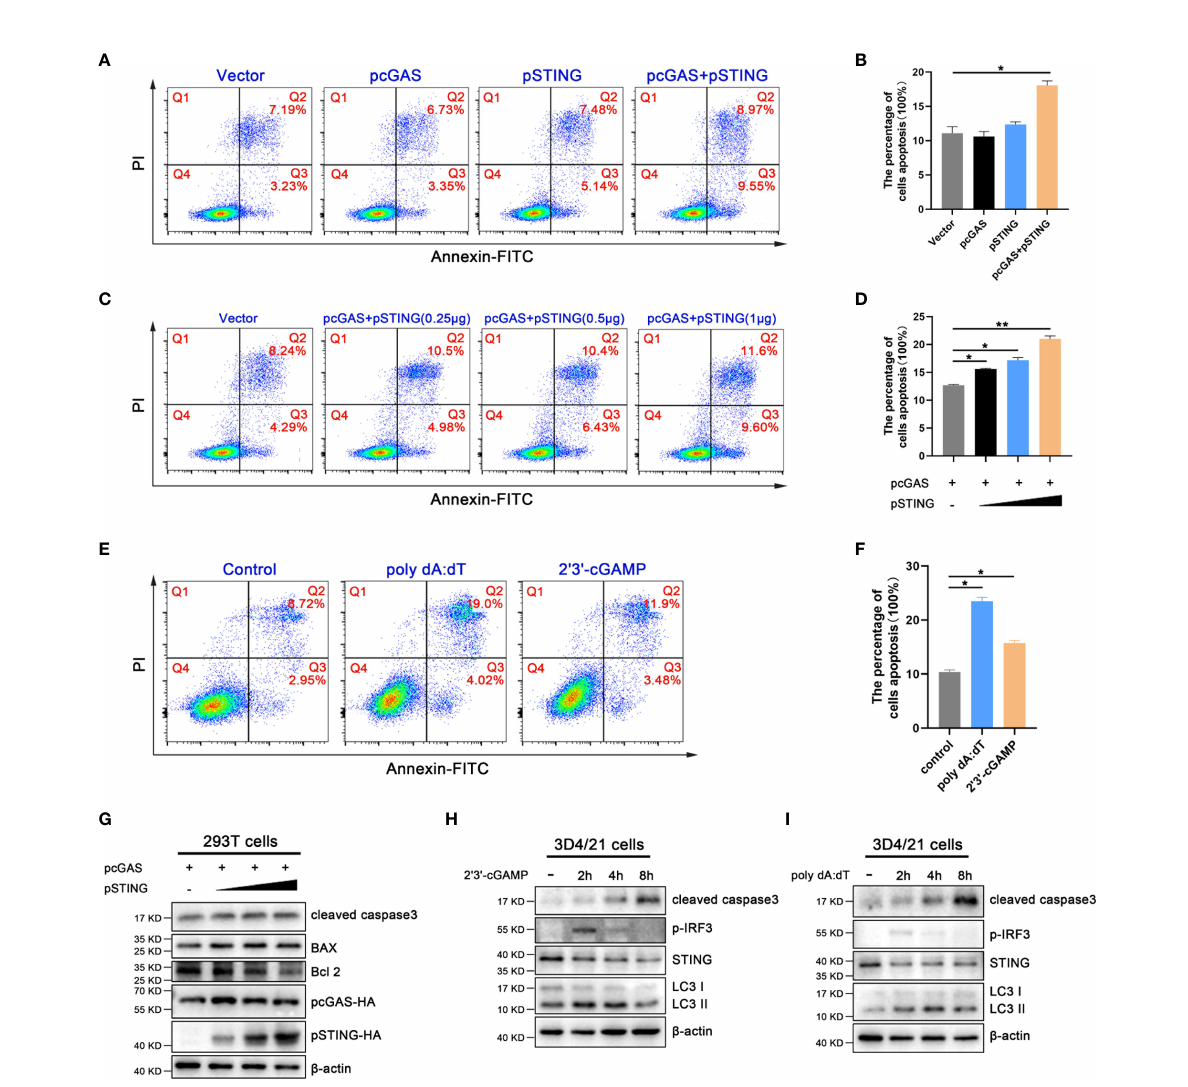
FIGURE 2 Activation of porcine cGAS-STING signal induces apoptosis. (A, B) 293T cells were transfected with pcDNA encoded pcGAS (0.5 m g), pSTING (0.5 m g) as indicated. (C, D) 293T cells were co-transfected with pcGAS (0.5 m g) plus pSTING at different amounts (0, 0.125, 0.25 and 0.5 m g). (E, F) 3D4/21 cells were stimulated by transfection of 2 ’ 3 ’ -cGAMP (1 m g/mL) or poly dA:dT (1 m g/mL) for 16 h. Cells were stained with Annexin V and PI followed by fl ow cytometry analysis. The percentages of cells in each quadrants of dot blots were indicated and apoptotic cell levels were presented in graphs. * p < 0.05 and ** p < 0.01. (G) 293T cells were co-transfected with pcGAS (0.5 m g) plus pSTING at different amounts (0, 0.125, 0.25 and 0.5 m g) for 24 h. (H, I) 3D4/21 cells were stimulated with 2 ’ 3 ’ -cGAMP or poly dA:dT (1 m g/mL) for the indicated times. Cells were analyzed by Western blotting for cleaved caspase 3